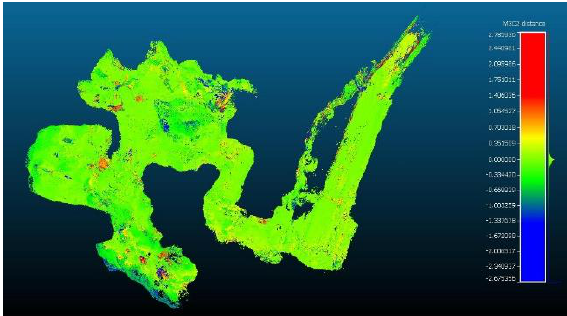
Figure 8. The coloured distances histogram on the error map.